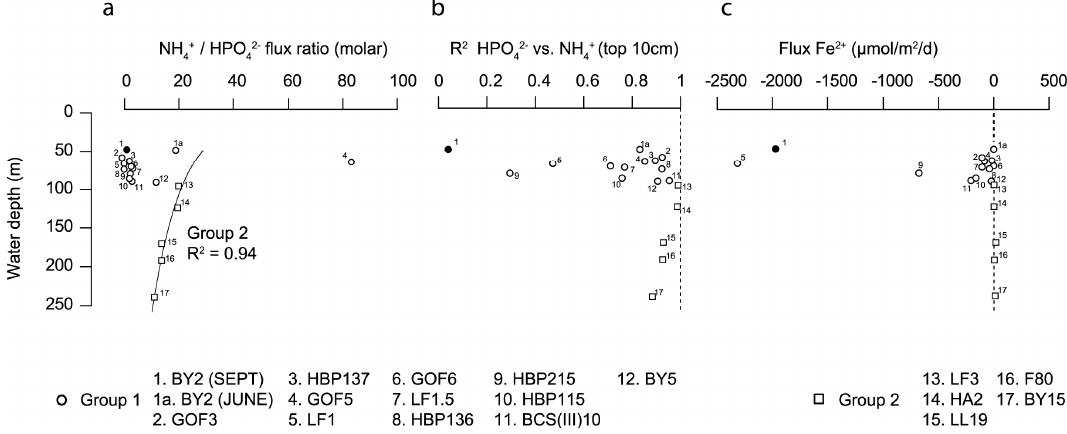
Figure 3. (a) Ratio of diffusive fluxes of NH 4+ / HPO 4- across the sediment-water 971